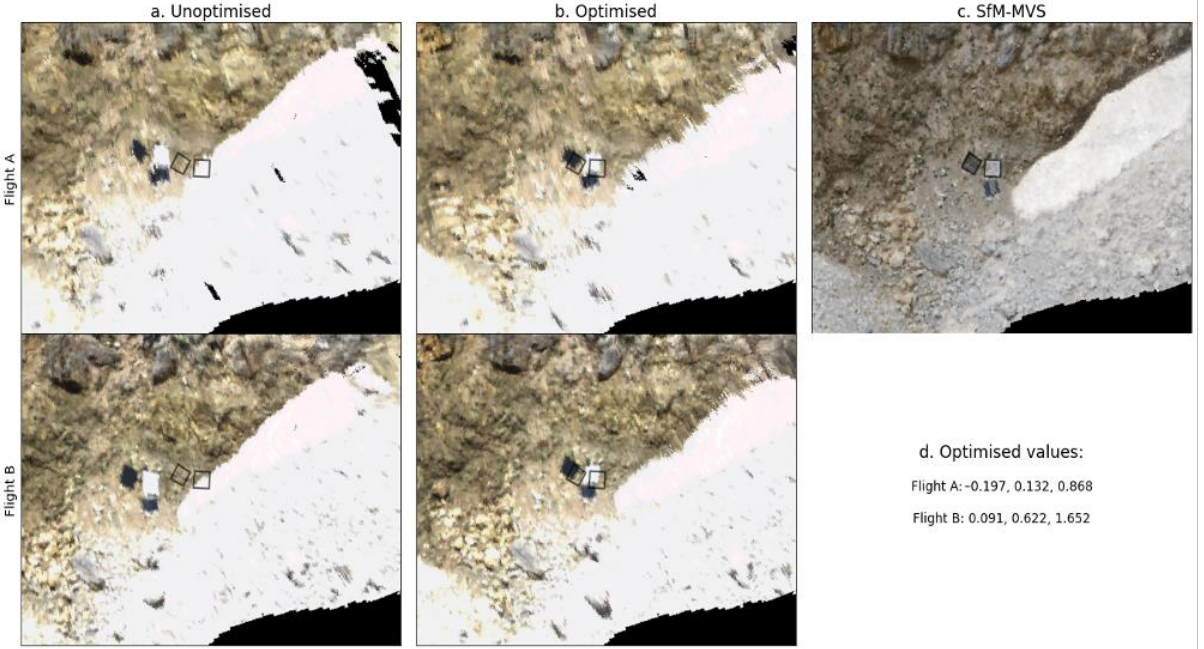
Figure 6. Geometrically corrected true-colour hyperspectral datasets before ( a ) and after ( b ) boresight optimisation for each flight. Outlines of the 1 m 2 grey and black calibration panels as mapped on the SfM-MVS point cloud ( c ) are overlain for reference. While there is significant room for improvement, coregistration error dropped from ~2.5 m before optimisation to ~0.2 m afterwards. Interestingly the optimal boresight values (roll, pitch, yaw in degrees) are substantially different between the two flights ( d ), even though these were conducted within an hour of each other. This suggests that they represent ‘virtual’ boresight values that correct for a misalignment between the global coordinate system and the IMU coordinate system caused by poor GPS signal during IMU calibration, rather than the real sensor boresight.